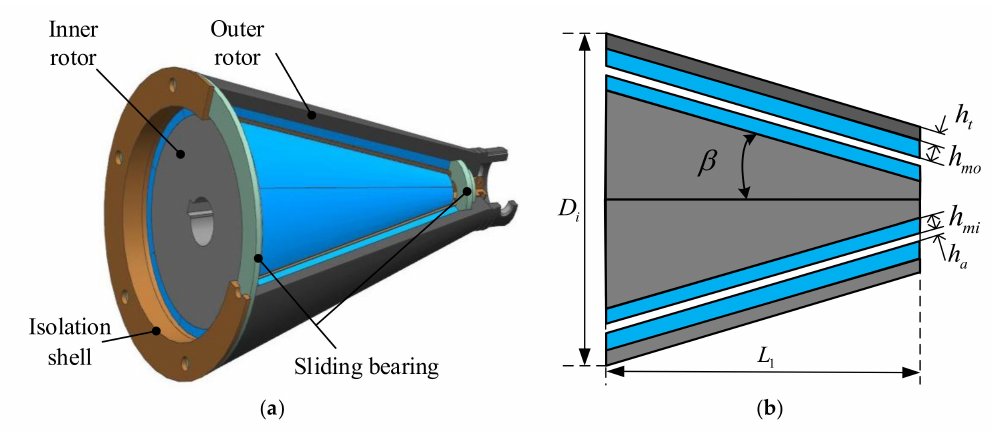
Figure 2. Structure of CPM ( a ) Components ( b ) Geometrical parameters.